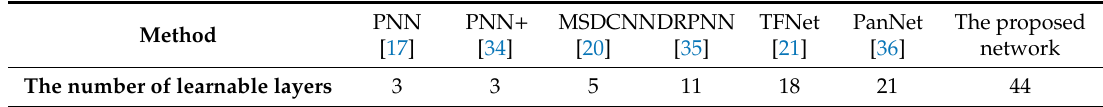
The number of learnable layers of di ff erent convolutional neural networks (CNNs) for